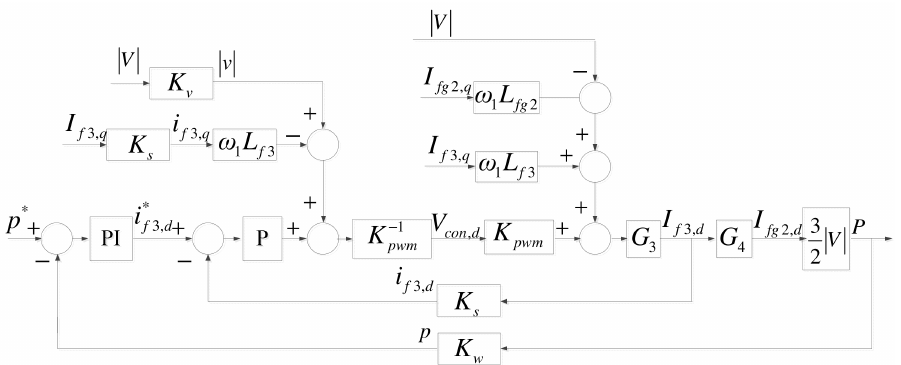
Figure 12. Complete MG inverter d-axis control loop.